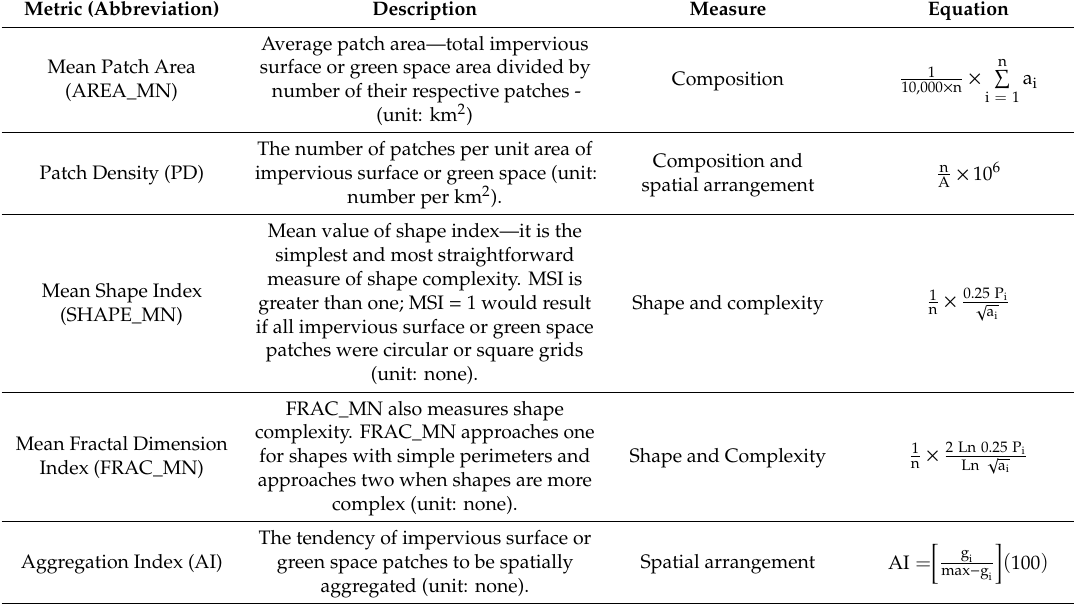
Table 2. Selected class level spatial